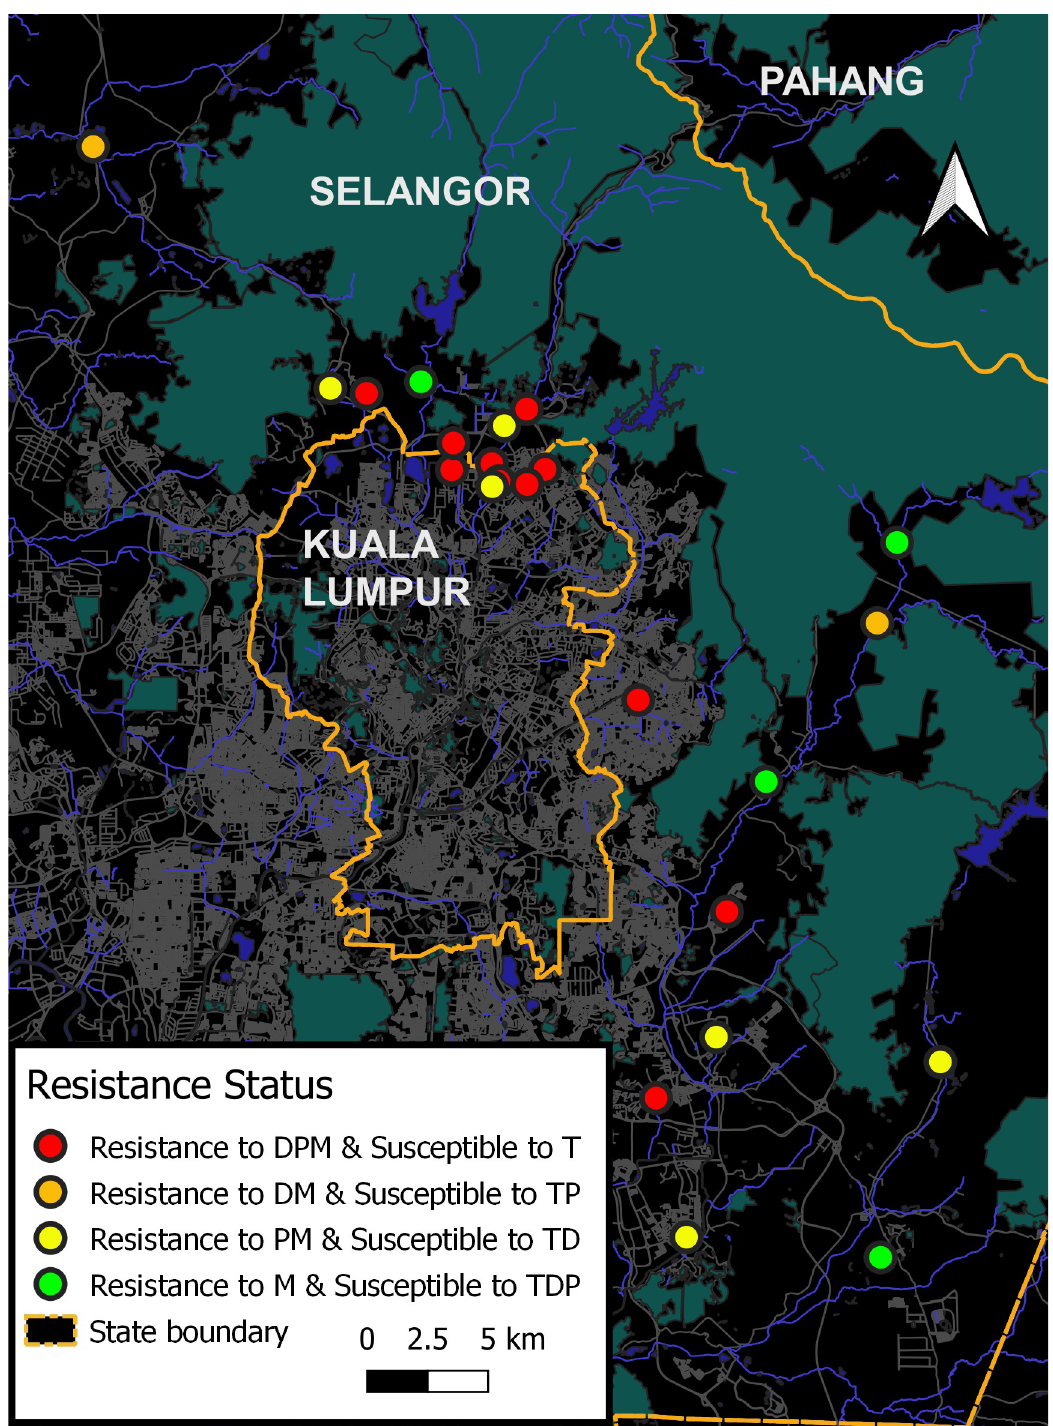
Fig 2. Insecticide susceptibility profile of Aedes albopictus populations. The code D, P, M, and T refers to deltamethrin, permethrin, malathion, and temephos, respectively.